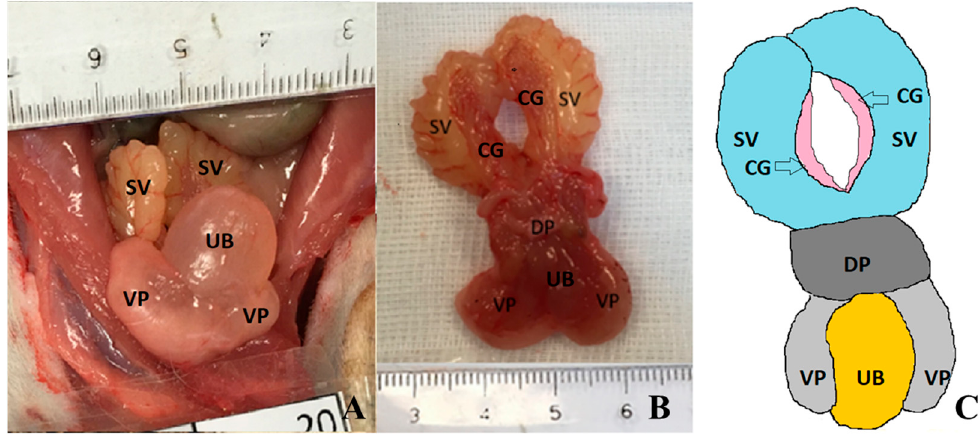
Figure 1. Macroscopic appearance of rat prostate and other surrounding anatomical structures at 61 weeks of age. ( A ) In situ photography of an animal from control group, ventral view; ( B ) Photography of prostate from an induced animal (dorsal view). Seminal vesicles and coagulative glands extended caudally. ( C ) Line diagram of prostate, urinary bladder and closed sex glands. Coagulating glands (CG), dorsal (DP) and ventral prostate lobes (VP), seminal vesicles (SV) and urinary bladder (UB).